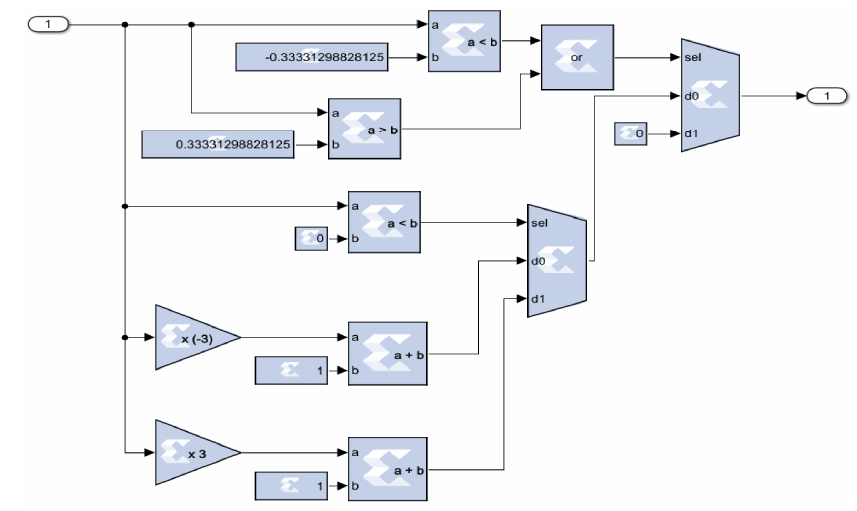
Figure 20. Design of ZE membership function from XSG.